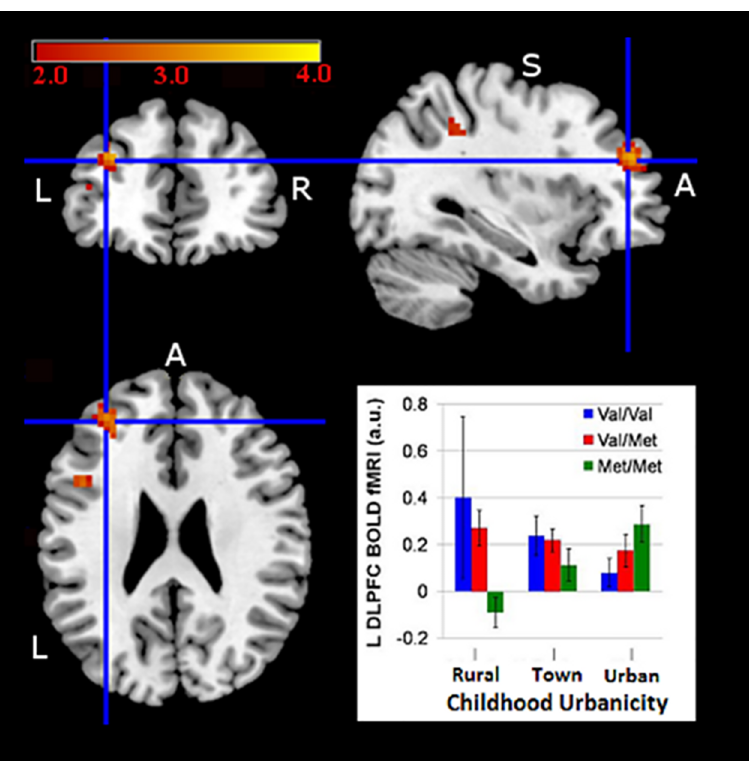
Fig 2. Urbanicity-by- COMT at discovery: Urban upbringing reversed the relationship between COMT and prefrontal working memory activation. Urbanicity-by- COMT interaction at discovery showing urban Met/Mets paradoxically over-activated relative to Val/Vals and contrasting with patterns found for rural and town. Our threshold for statistically significant regions survived family-wise error, small volume correction (FWE SVC) p < 0.05. Abbreviations: L = left, R = right, X, Y, Z coordinates from MNI = Montreal Neurological Institute. BOLD graphed as mean ± 1 standard error (a.u. or arbitrary units) with the color bar above representing activation significance. Left = Left, A = anterior, L = left, R = right, S = superior.